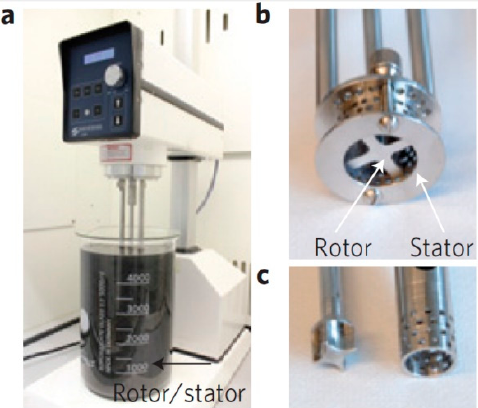
Figure 29. ( a ) A Silverson model L5M high-shear mixer with mixing head in a 5 L beaker of graphene dispersion. Close-up view of a D = 32 mm mixing head ( b ) and D = 16 mm mixing head with rotor (left) separated from stator ( c ). Reproduced from [19]. Copyright Nature Publishing Group, 2014.